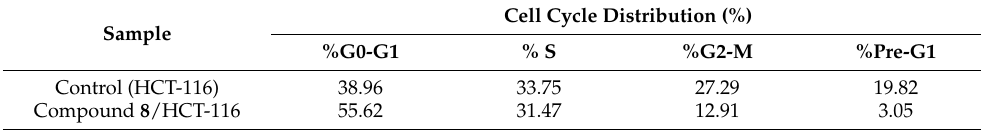
Table 4. Effects of compound 8 (5.4 µ M) on cell cycle phases of HCT-116 cells after treatment for 24 h.